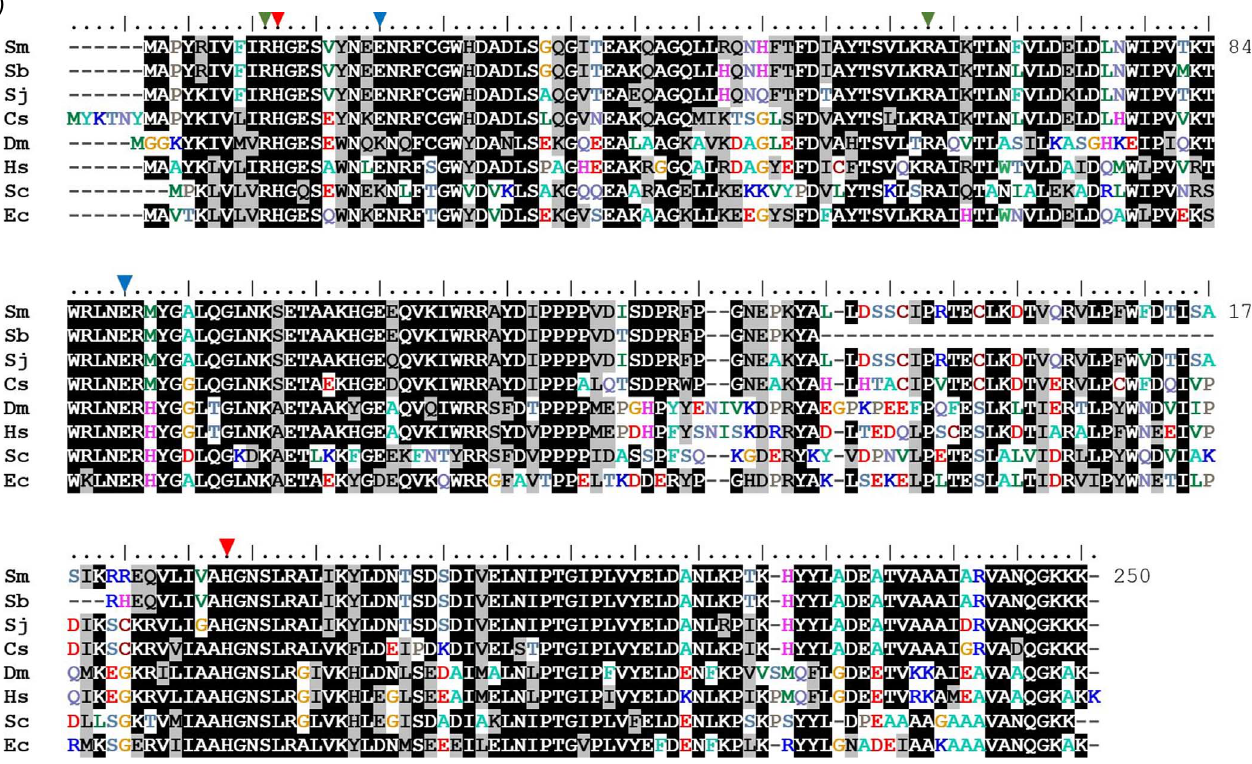
Figure 4. (A) Sequence alignment of Schistosoma mansoni PGM (Sm) and select dPGMs from other organisms. Identical amino acid residues between sequences are shaded in black. Similar amino acid residues between sequences are shaded in gray. Important conserved residues are marked with arrowheads: the histidine residues (red), arginine residues (green), and glutamate residues (blue) have been reported to stabilize the active site and participate in binding and catalysis of the substrate 3-phosphoglycerate. The accession numbers of the aligned PGMs are as follows: Schistosoma mansoni Sm (OK490368.1), Schistosoma bovis Sb (RTG81826.1), Schistosoma japonicum Sj (Q8WT66), Clonorchis sinensis Cs (AAX29976.1), Drosophila melanogaster Dm (Q9VAN7), Homo sapiens Hs PGAM1 (P18669), Saccharomyces cerevisiae Sc (P00950), Escherichia coli Ec 2,3-bisphosphoglycerate-dependent PGM (P62707). (B) Phylogenetic tree of phosphoglycerate mutases. A phylogenetic tree of phosphoglycerate mutases constructed by Molecular Evolutionary Genetics Analysis (MEGA) Version 7.0.21 software using amino acid sequences obtained from the UniProt database. The optimal tree with the sum of branch length = 5.29 is shown. The scale bar represents the number of substitutions between sequences. Evolutionary distances were computed using the Poisson correction method. The analysis involved 19 amino acid sequences. The species names and UniProt accession numbers for the sequences are as follows: Schistosoma mansoni (UFA46002), Schistosoma japonicum (Q8WT66), Schistosoma bovis (RTG81826.1), Homo sapiens PGAM1 (P18669) and PGAM2 (P15259), Mus musculus PGAM1 (Q9DBJ1) and PGAM2 (O70250), Drosophila melanogaster (Q9VAN7), Escherichia coli